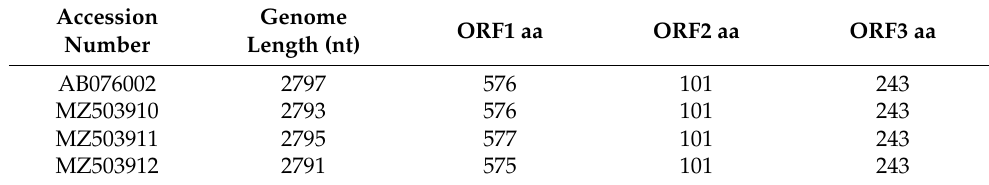
Table 3. Comparison of ORF1, 2, and 3 of three strains with TTCaV prototype